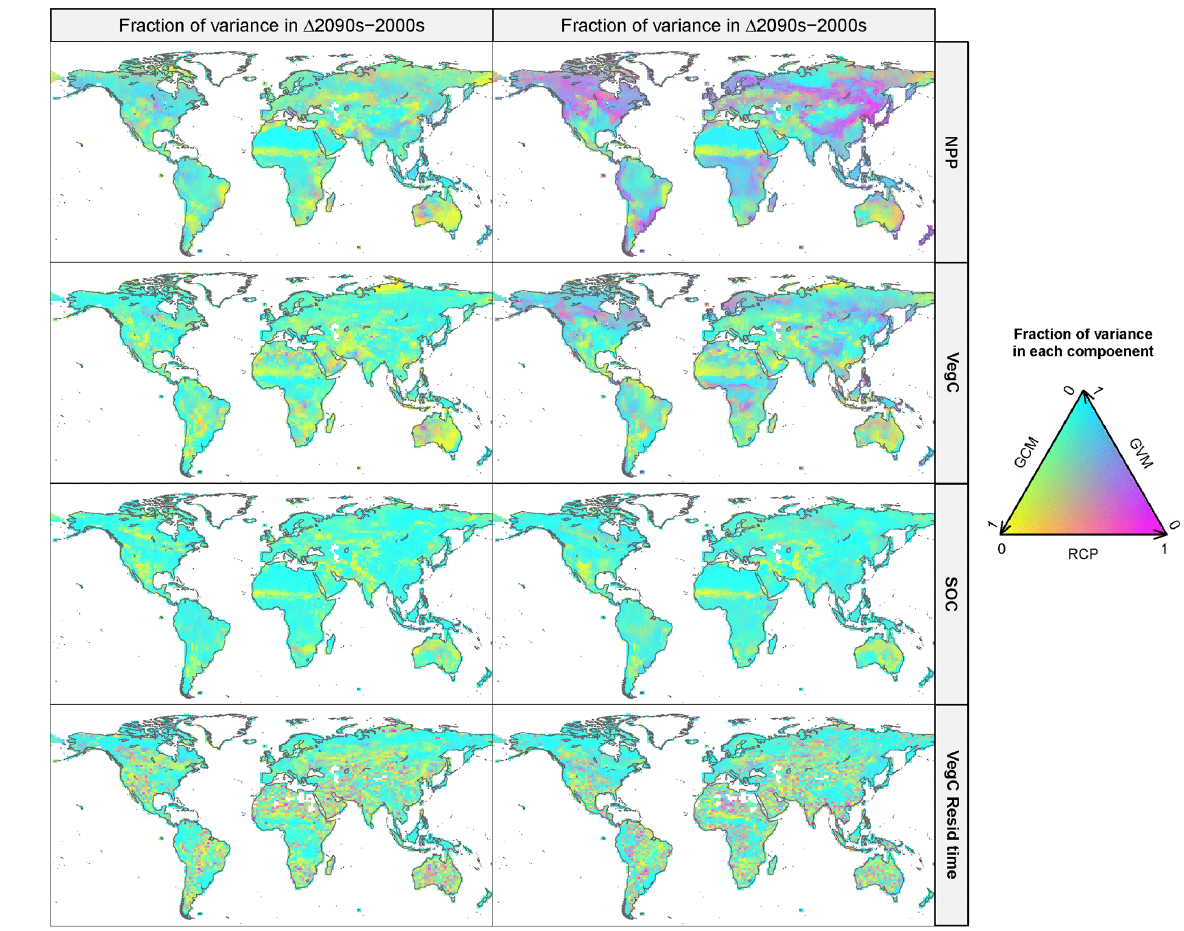
Figure 3. Geographic distribution of the relative importance of the uncertainty derived from the emission scenarios (RCPs), GCMs, and GVMs for annual NPP, VegC, SOC, and VegC residence time changes from 2000 to 2050 and 2099 in each grid cell. The variances were estimated by one-way